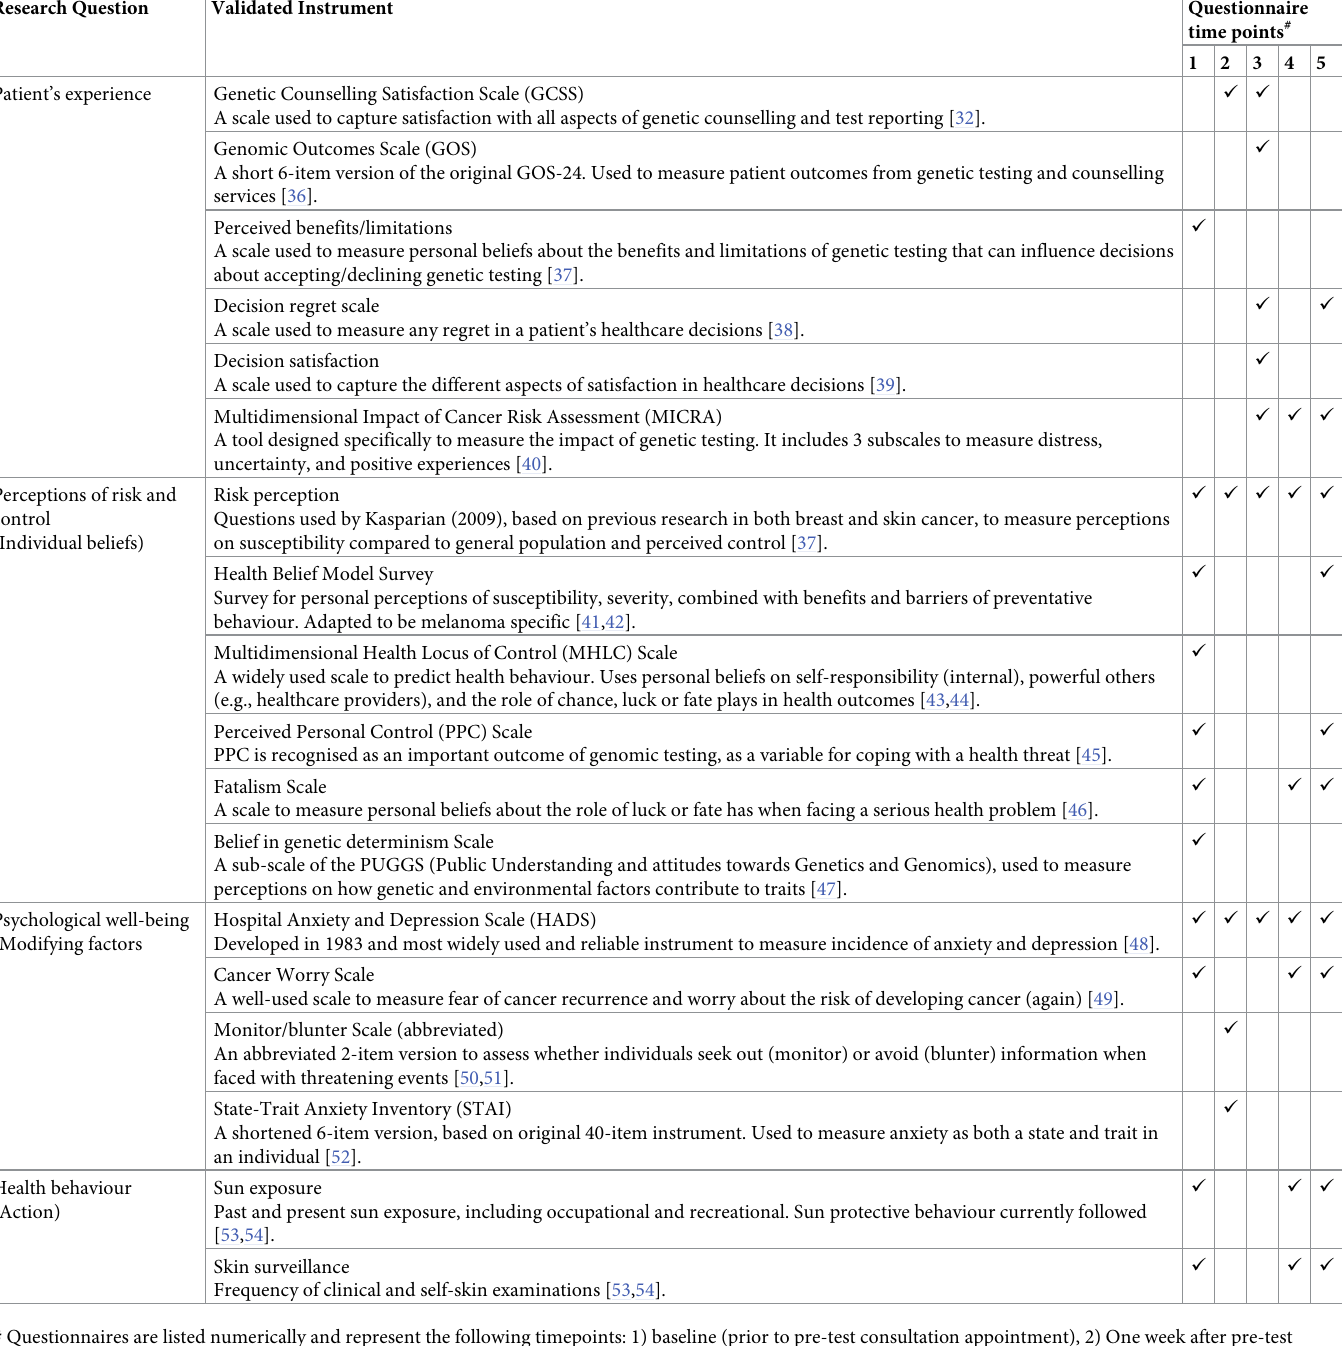
Table 1. A list of the different instruments used to address research questions, across the five questionnaire timepoints. Research